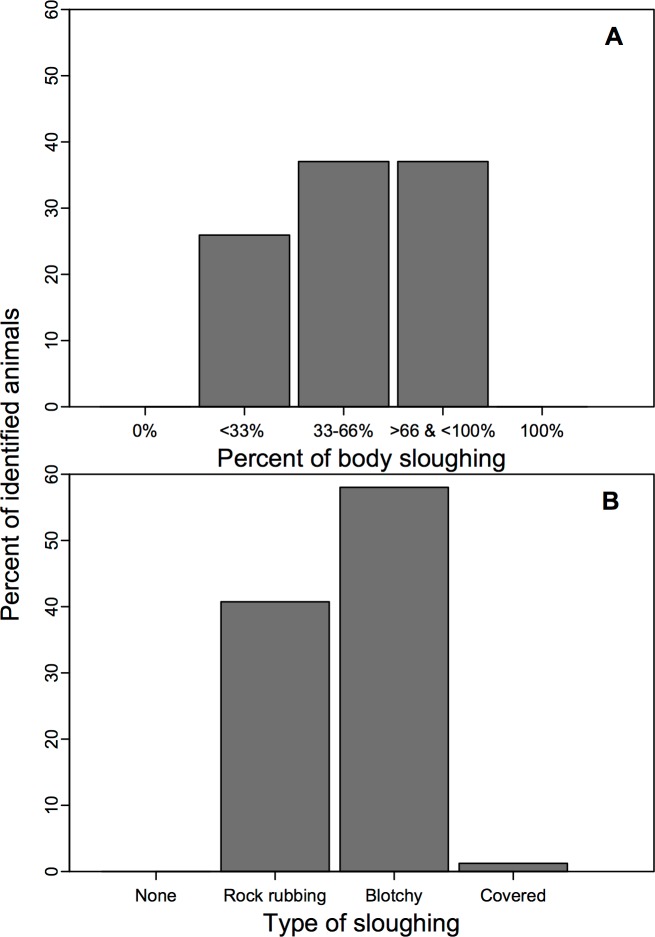
Percentage of photographically identified bowhead whales with sufficient image quality to quantify the amount of the body containing sloughing skin (n = 81) (A). Overall, all animals showed signs of molting in late August, and no animals had bodies with 100% new skin cover. Also shown is type of sloughing skin (B) whereby ‘none’ represents animals with no skin irregularities, ‘rock rubbing’ is indicated by animals with both sharp, thin light gray lines and/or wider, less pronounced light gray lines which are likely a result of prior rock rubbing, ‘blotchy’ comprises animals with irregular patches of new epidermis and ‘covered’ includes animals with extensive new skin growth.